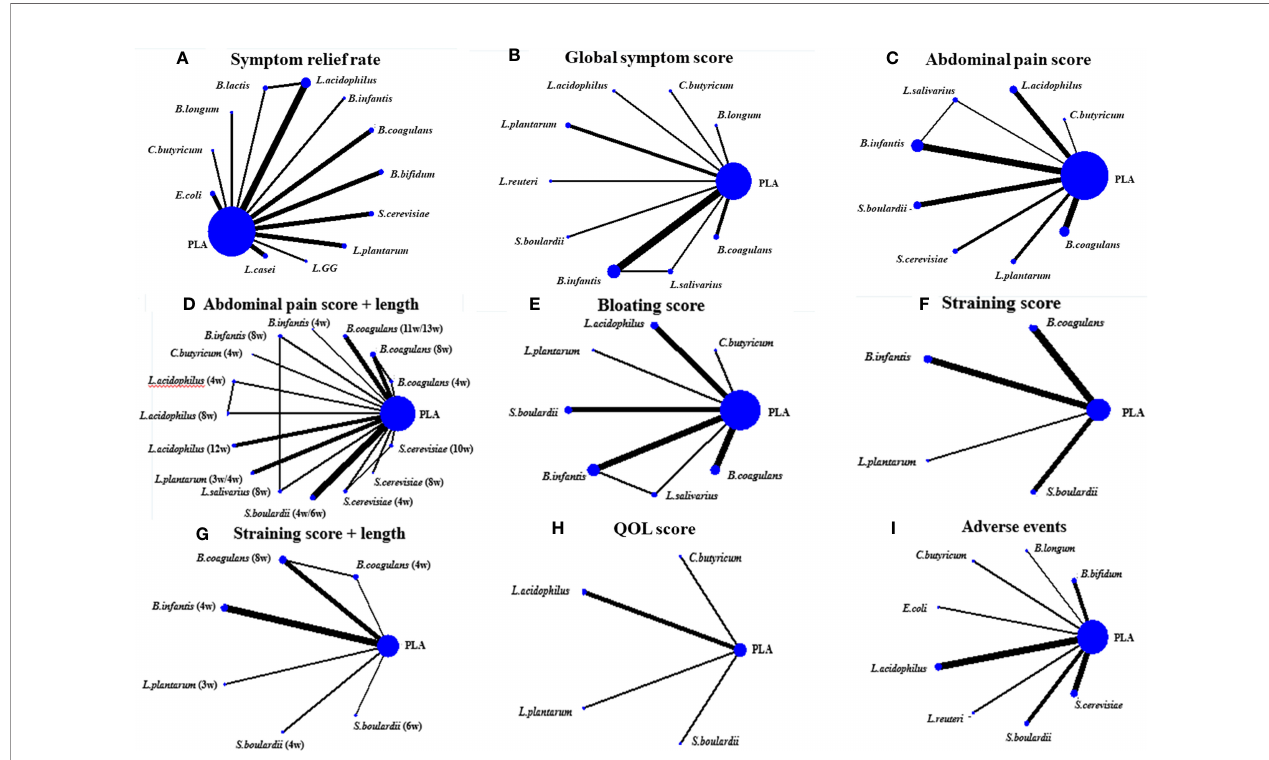
FIGURE 2 | The network plots. (A) was the network plot about the effect of probiotics on improving the symptom relief rate of IBS patients; (B) Global symptom score; (C) Abdominal pain score; (D) Bloating score; (E) Straining score; (F) QOL score; (G) Adverse events; (H) Subgroup analysis on treatment length of probiotics for improving the abdominal pain of IBS patients; (I) Subgroup analysis on treatment length of probiotics for improving the straining scores of IBS